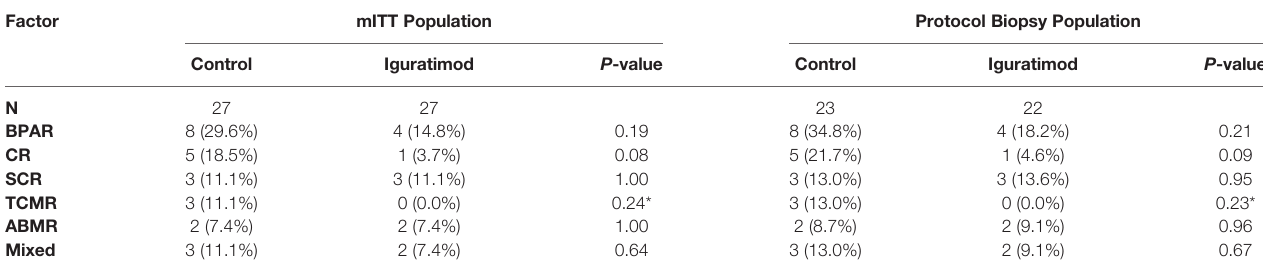
TABLE 2 | Univariable analysis of rejection rate between two groups. Factor mITT Population Protocol Biopsy